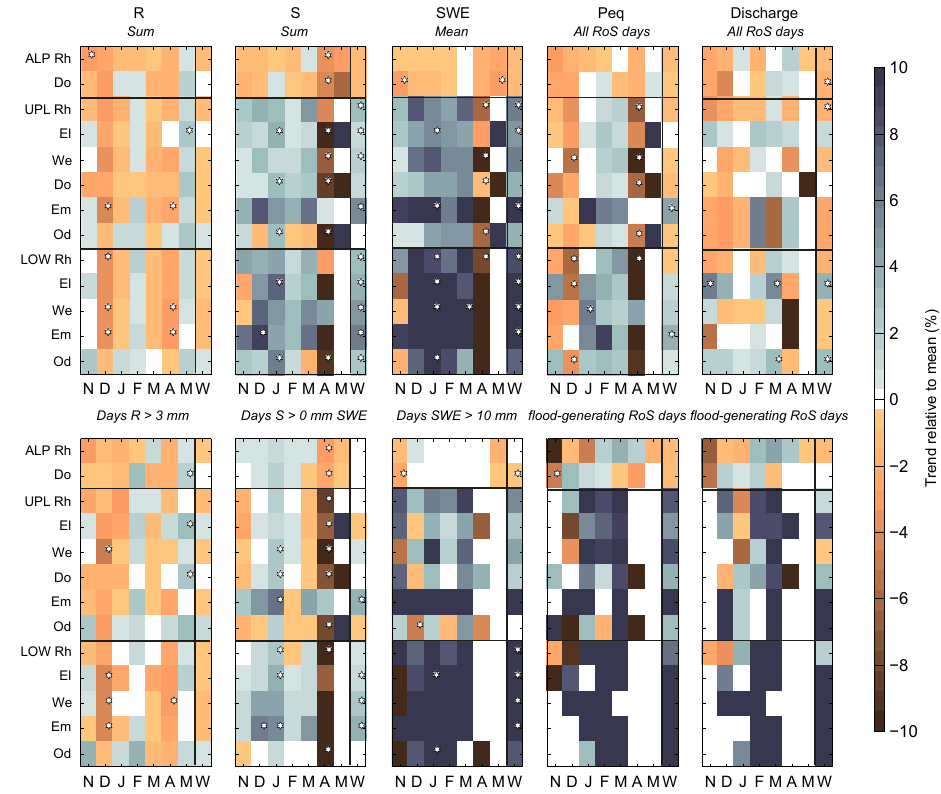
Figure 7. Comparison of the short-term trends (1990–2011) of the total equivalent precipitation depth, the snow water equivalent, the snowfall, and the rainfall for the individual months November–May (N–M) and the winter season (W) for the alpine (ALP), upland (UPL) and lowland (LOW) sub-basins of the Rhine (Rh), Danube (Do), Elbe (El), Weser (We), Oder (Od), and Ems (Em). Trends are given as the yearly change relative to the mean of the period 1990–2011. Statistically significant trends at p < 5% are shown with a red star.